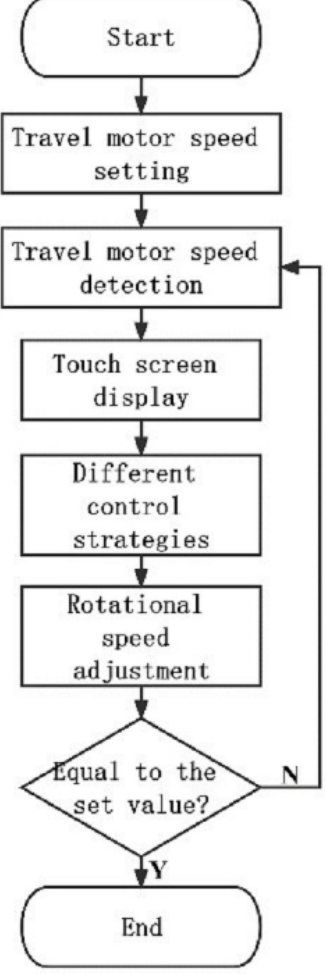
Figure 3. Flow chart of the automatic travel speed control program.